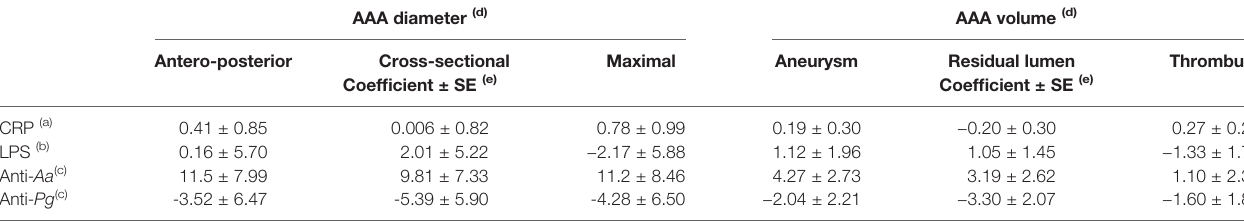
TABLE 3 | Relationship between the blood concentrations of CRP, LPS, Aa , and Pg antibodies, and the AAA diameters and volumes ( N =